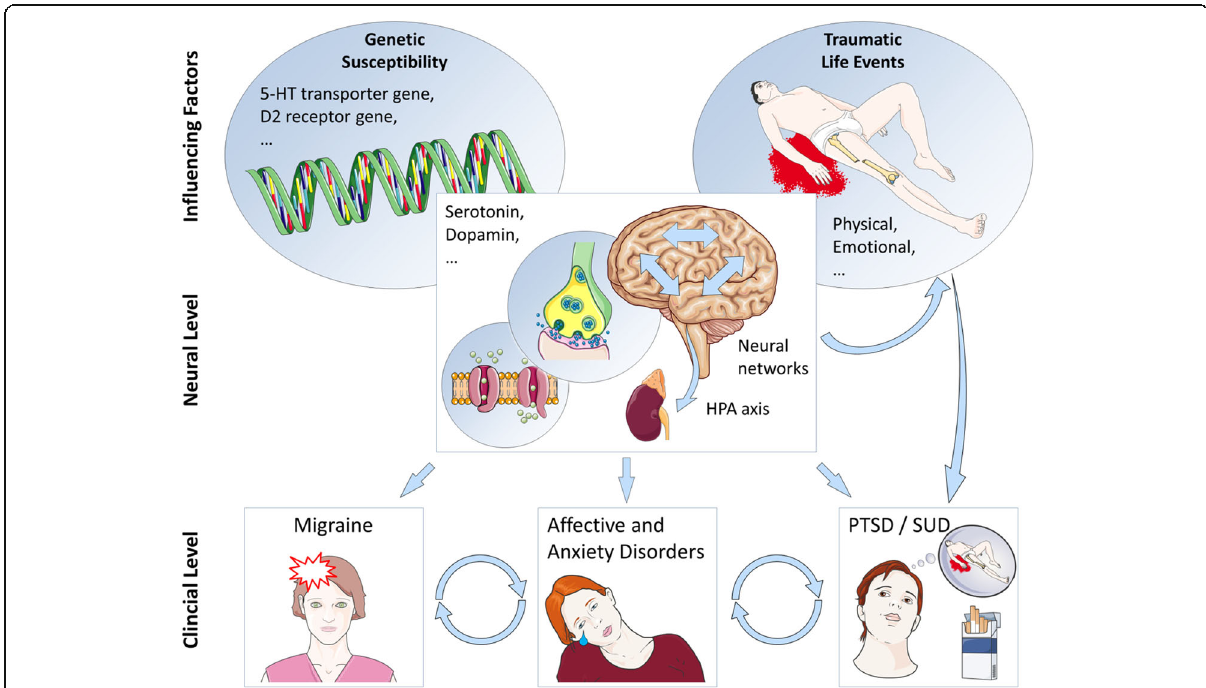
Fig. 2 Scheme of the association mechanisms between migraine and psychiatric disorders. The Figure summarizes the mechanisms potentially involved in the comorbidity of migraine and psychiatric disorders on different levels. Shared genetic susceptibility and traumatic life events can be considered important influencing factors. On the neural level, cellular changes (channels), neurohormonal changes (HPA axis), neurotransmitter changes (serotonergic, dopaminergic, and glutamatergic neural pathways) and neural network changes are discussed. On the clinical level, migraine co-occurs with different manifestations of psychiatric disorders (for abbreviations see